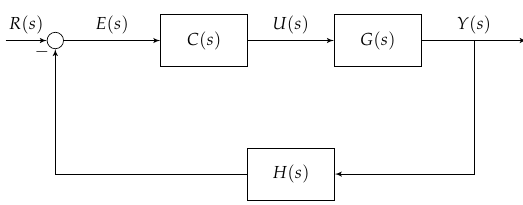
Figure 1: Block diagram of the closed-loop control system. Figure 1. Block diagram of closed loop control system.